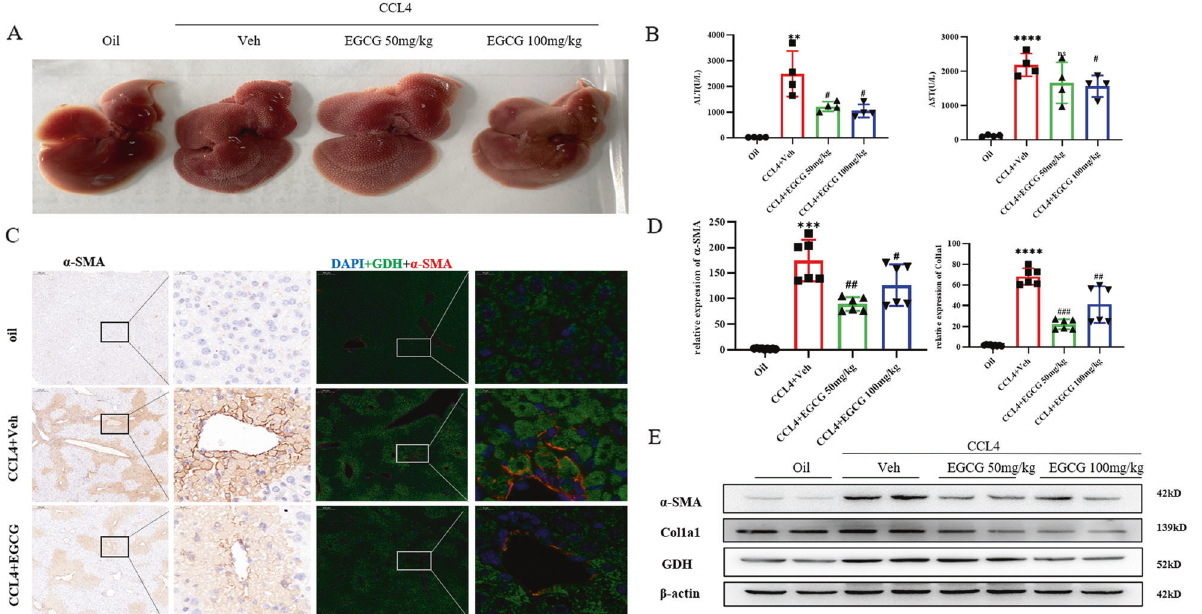
Fig. 2 Glutaminolysis activates myo fi broblastic HSCs in acute liver injury. A Representative images showing the liver morphology in each group at sacri fi ce. B ALT and AST levels in serum. C Immuno fl uorescence and immunohistochemistry analysis of α ‐ SMA and GDH expression (scale bars = 200 μ m or 20 μ m). D Real ‐ time quantitative PCR analysis of the mRNA expression of fi brotic genes. E Western blot analysis of the protein expression of α ‐ SMA, Col1a1 and GDH. All the parameters evaluated were signi fi cantly decreased after EGCG treatment. The data are reported as the mean ± SD. * p < 0.05; ** p < 0.01; *** p < 0.001, **** p < 0.0001 versus the oil group. # P < 0.05, ## P < 0.01, and ### P < 0.001 versus the CCL4 + Veh